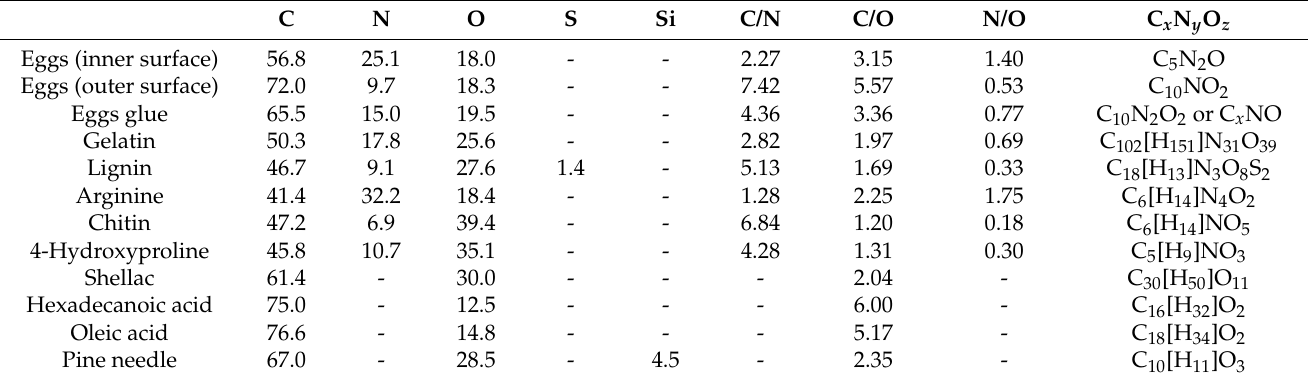
Table 1. EDS elemental analyses and C/N, C/O, and N/O ratios of L. occidentalis eggs and egg glue components, together with those of potentially associated organic chemicals.